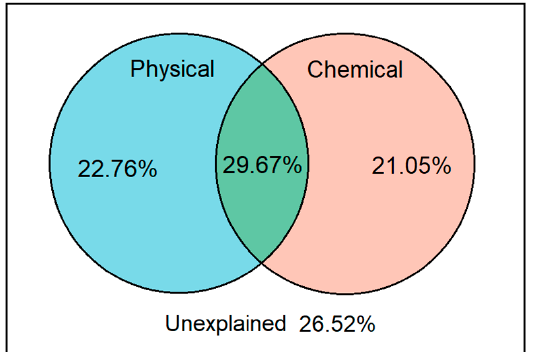
Figure 5. Variation partition analysis (VPA) for soil bacterial communities across the five land use patterns in the Tianzhu alpine agro-pastoral ecotone.